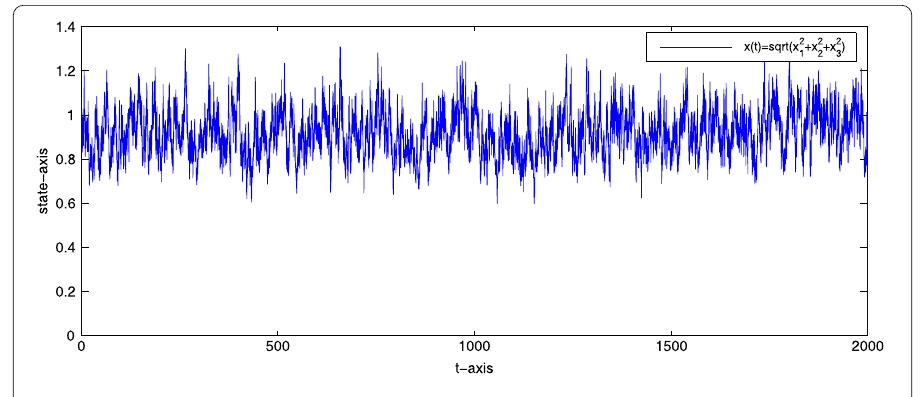
Figure 2 System (1.2) is stochastically permanent when γ 1 ( u ) = 0.2, γ 2 ( u ) = 1, γ 3 ( u ) = 3